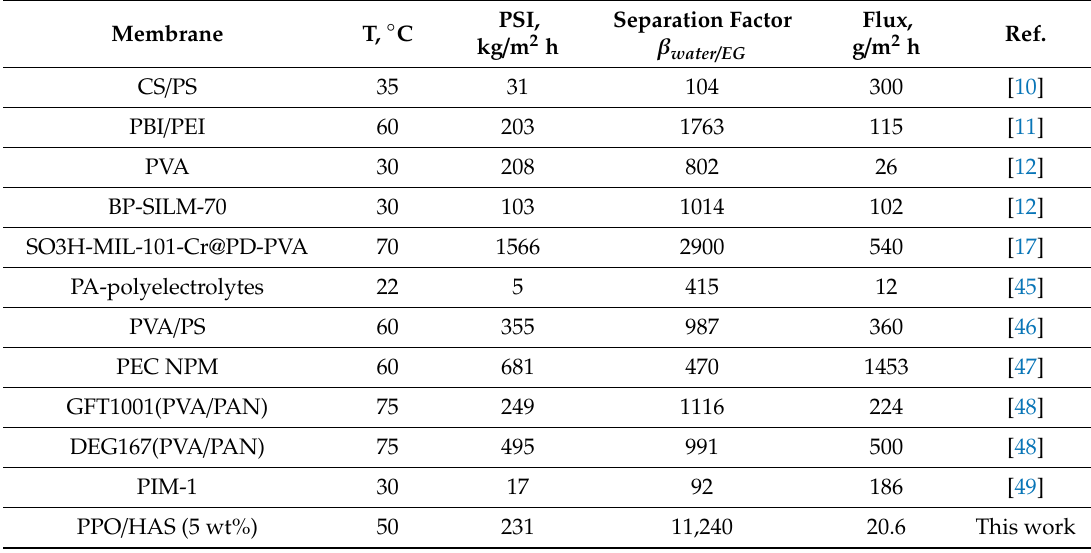
Table 4. Comparison of transport properties of polymer membranes in the pervaporation of the EG / water mixture (water content 10